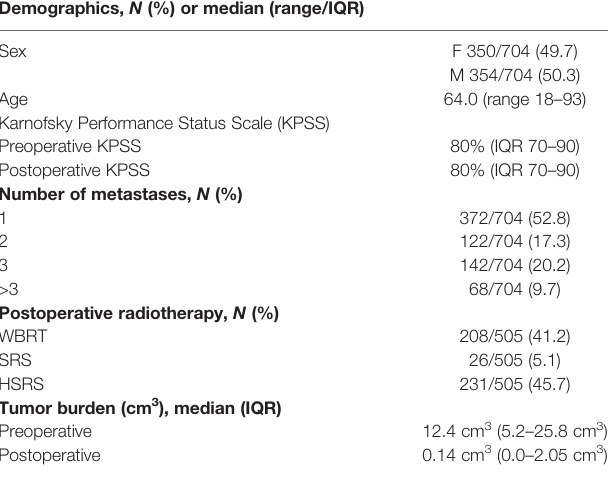
TABLE 1 | Demographics and tumor